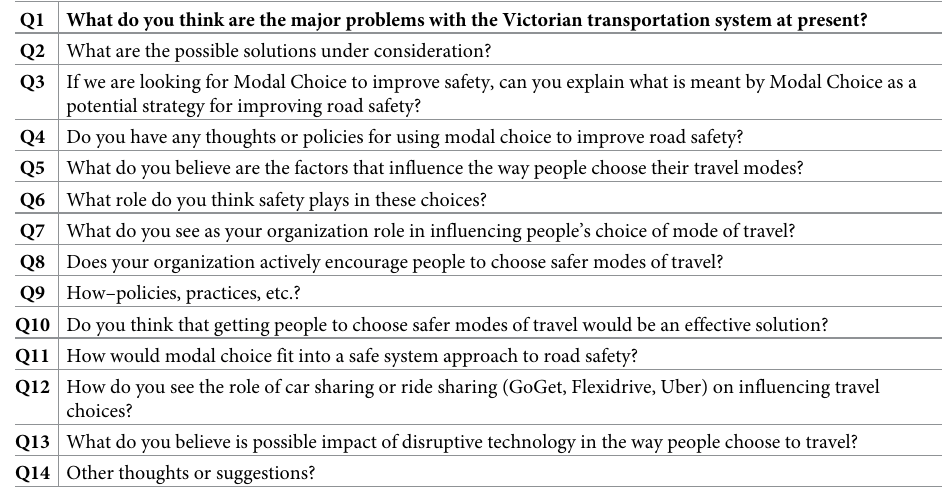
Table 2. The semi-structured interview